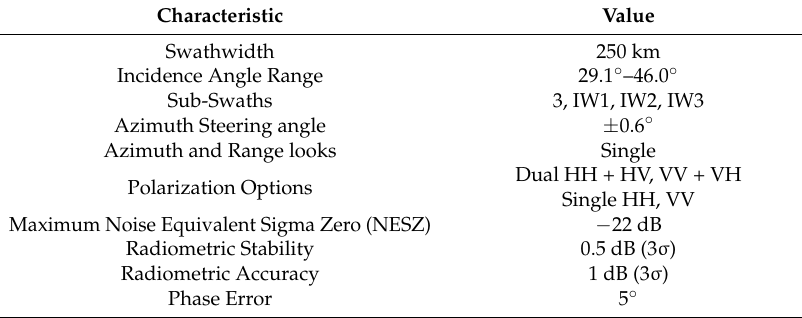
Table 1. Characteristics of Sentinel-1 interferometric mode